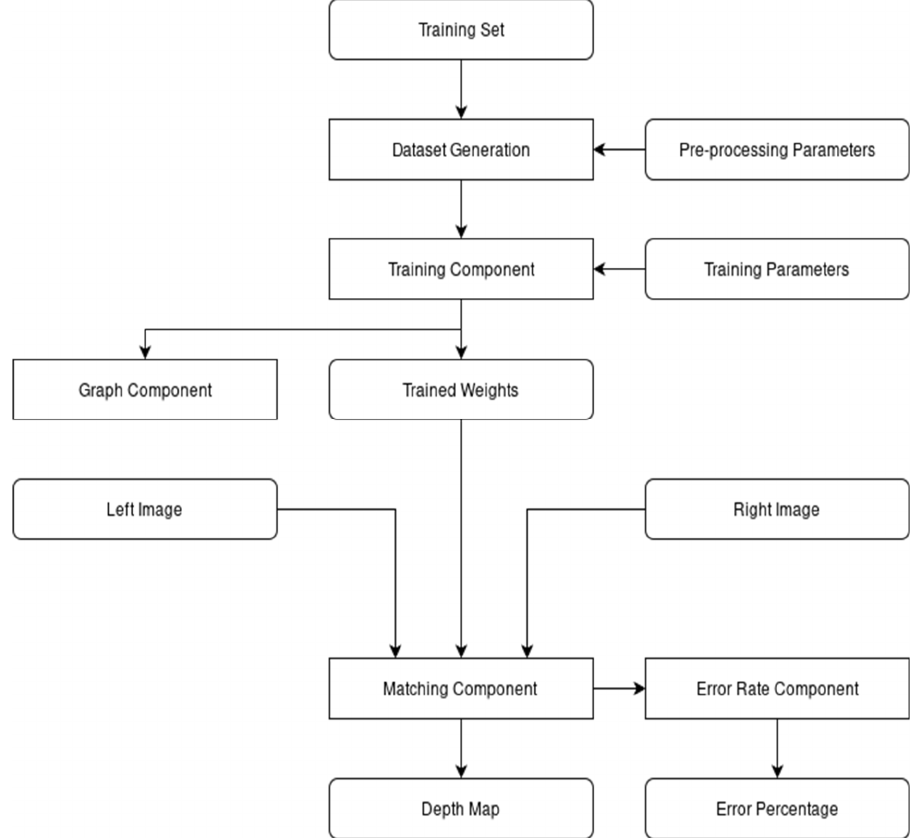
Figure 1. The architecture of the